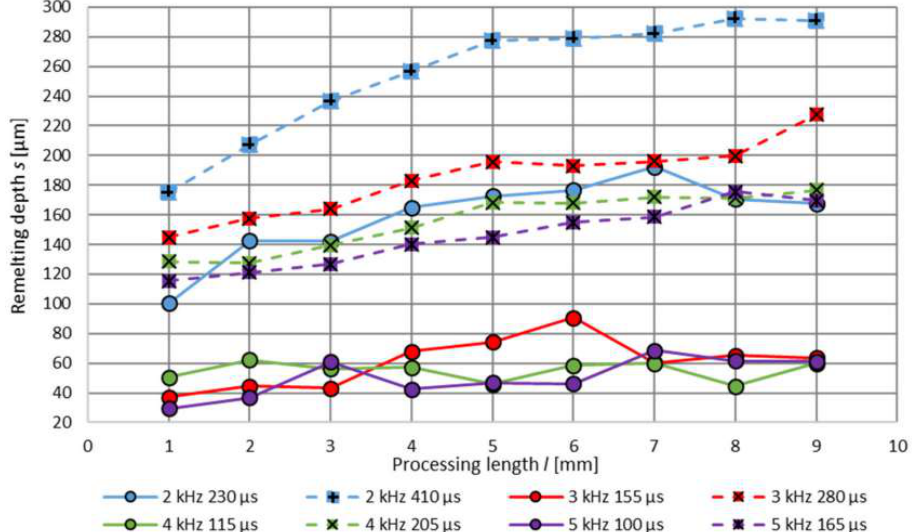
Figure 30. Resulting remelting depth s depending on the processing length l and process parame- ter